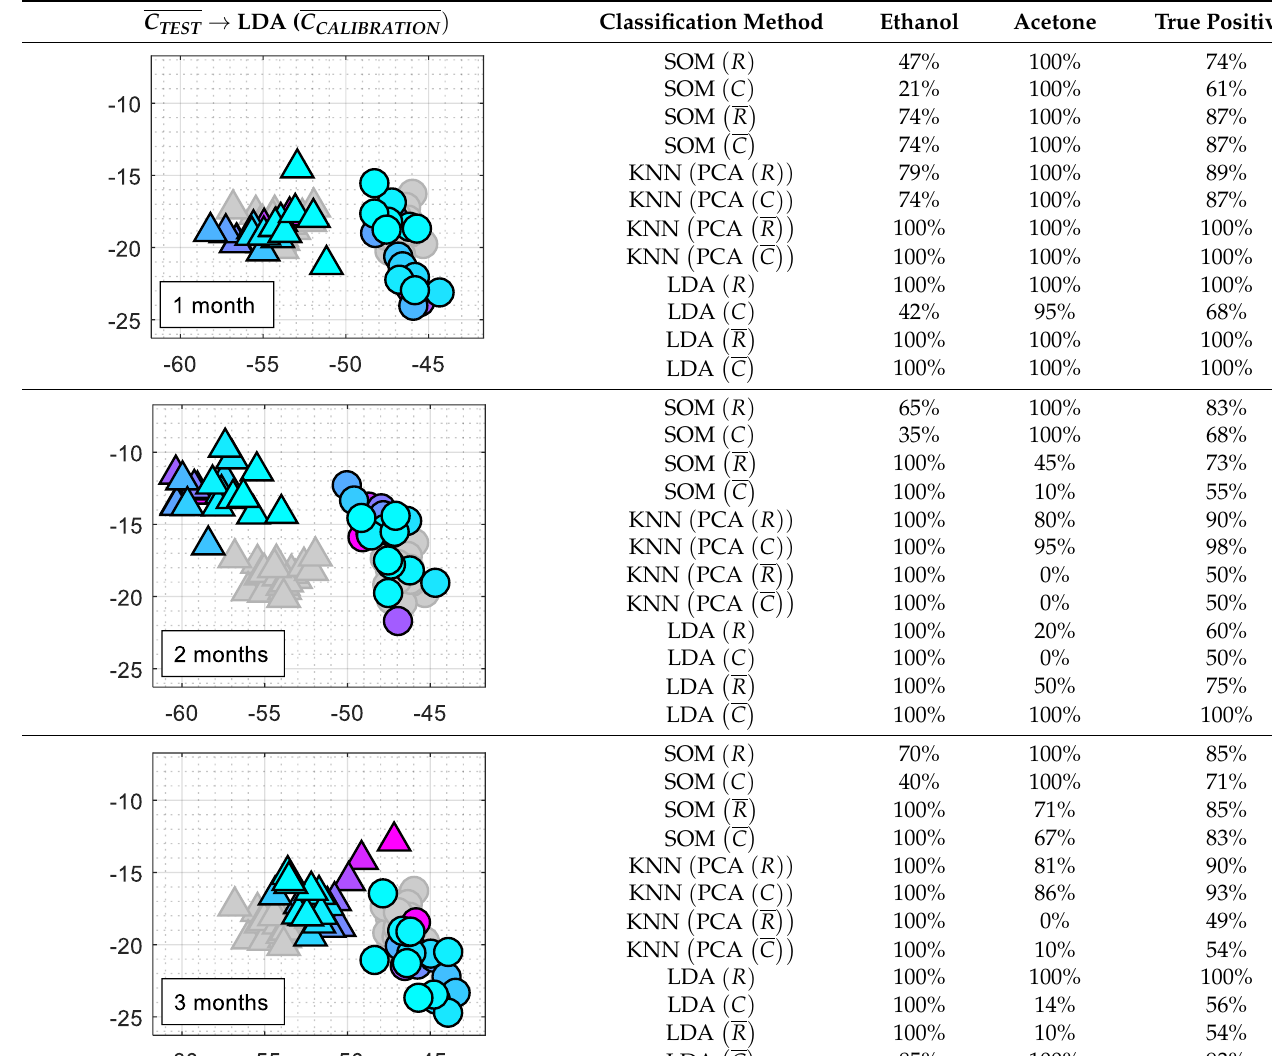
Table 5. Classification results obtained with the different classification methods assessed: comparative projection of the test data in the space defined by the two principal components of the LDA analysis of the calibration data, classification methods assessed, samples correctly classified as ethanol (triangle) and acetone (circle), and average true